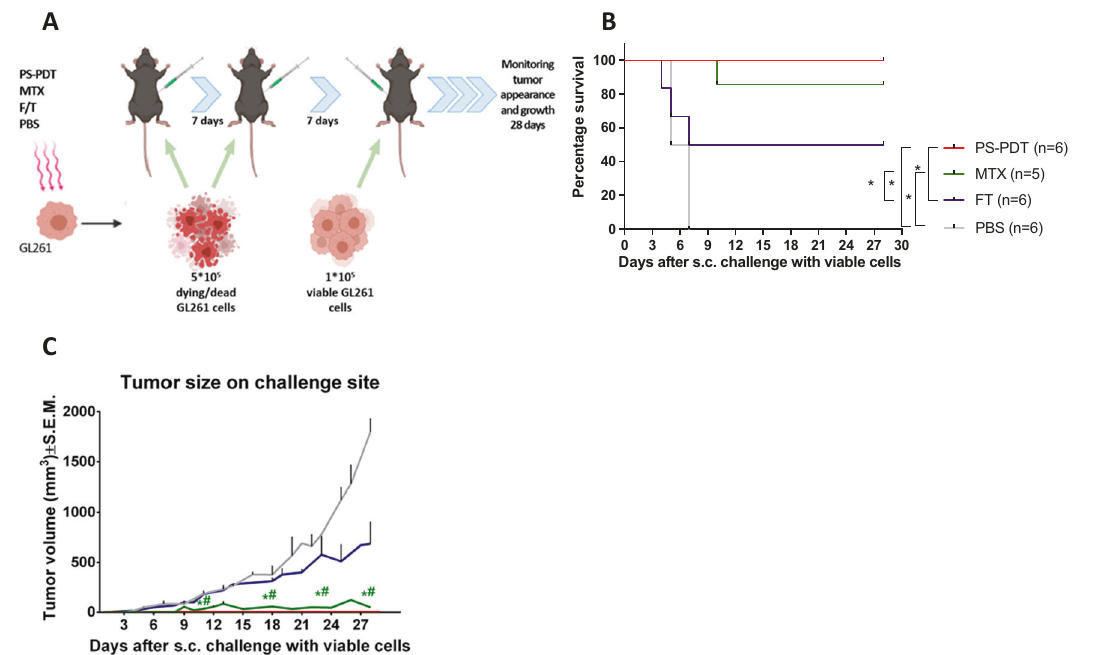
Fig. 1 Vaccination with glioma GL261 cells pulsed with PS-PDT in the subcutaneous prophylactic vaccination mouse model. A Prophylactic vaccination of mice was performed by injecting them in the left fl ank on days 0 and 7 with dying/dead GL261 cells treated with three F/T cycles, 2.0 µM MTX, or PS-PDT, or by injecting them with PBS (negative control). Seven days later, the mice were challenged with viable GL261 cells in the right fl ank. B Tumor appearance (% survival) and growth C at the challenge site in mice subjected to vaccination and challenge with viable GL261 cells; n = 5 – 6 per group. *Statistically signi fi cant difference from the PBS group, ( p < 0.05); # statistically signi fi cant difference from the F/T group, ( p < 0.05), Wilcoxon